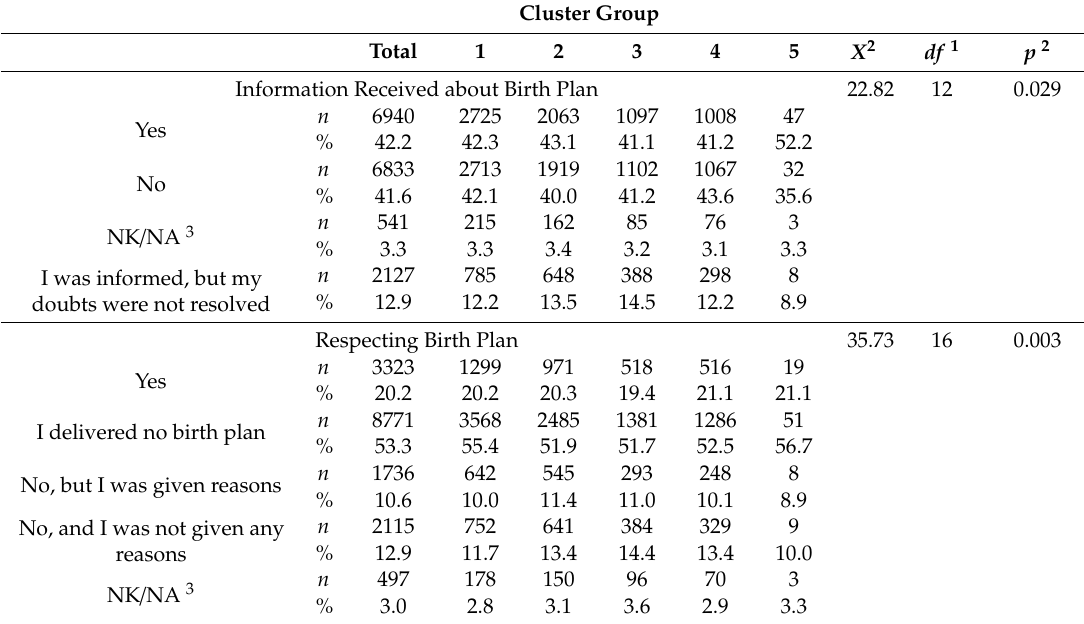
Table 4. The bivariate analysis results of the variables related to birth plan.